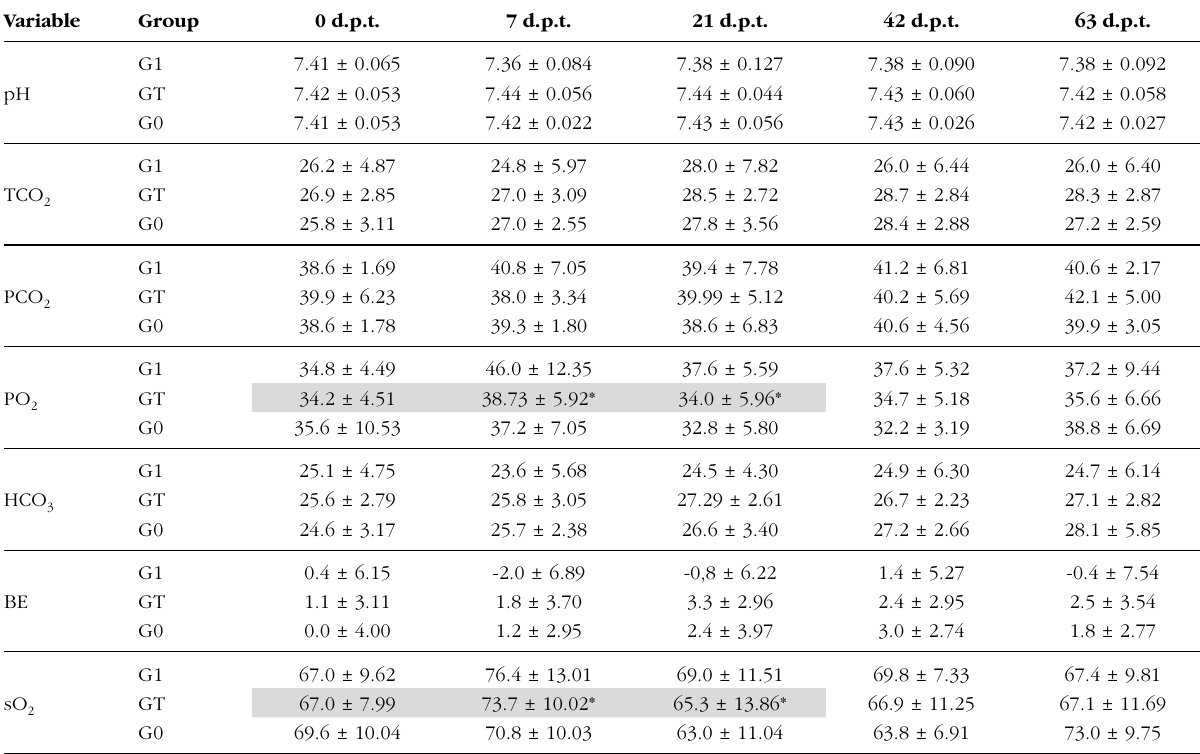
Table ii. – arithmetic mean ± standard deviation of pH and blood gas tension of the uninfected (g0), positive control (g1) and all treated groups (gT) measured using the i-sTaT portable clinical